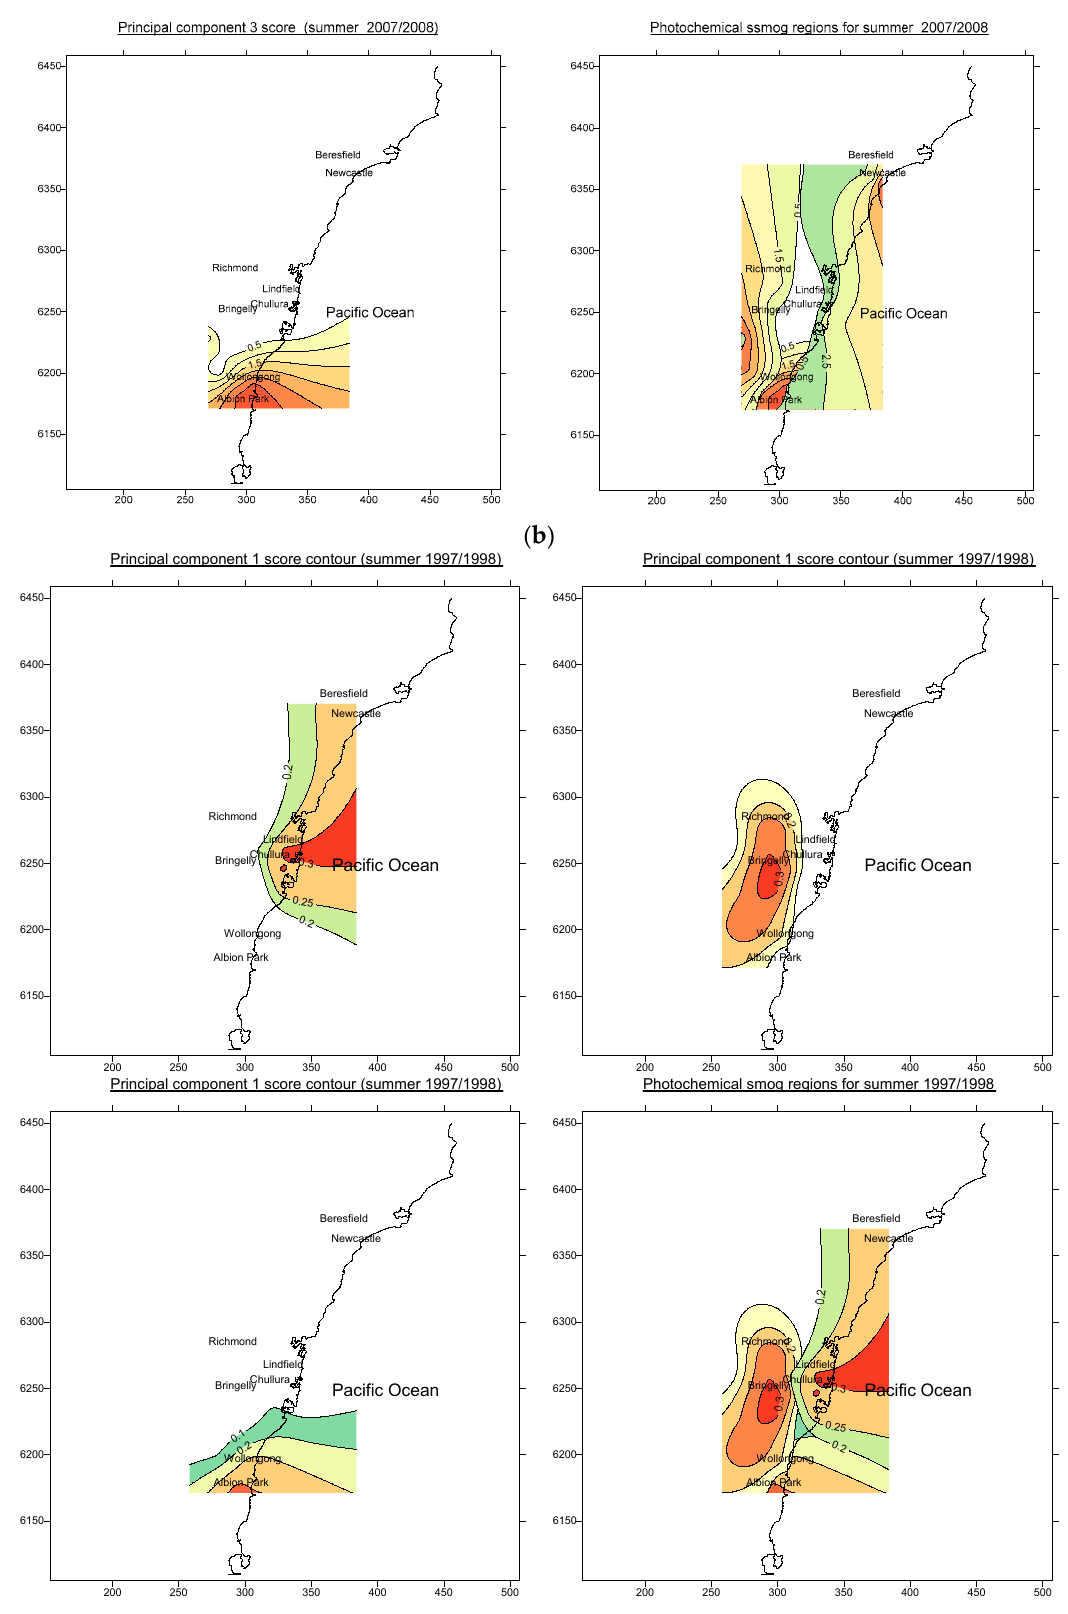
Figure 5. Contour plots of the first 3 principal component scores depicting the regional delineation based on similarity of ozone formation pattern in ( a ) 2007/2008 and in ( b ) 1997/1998. The last plot in each graph is the combined plots of the 3 component score contours.